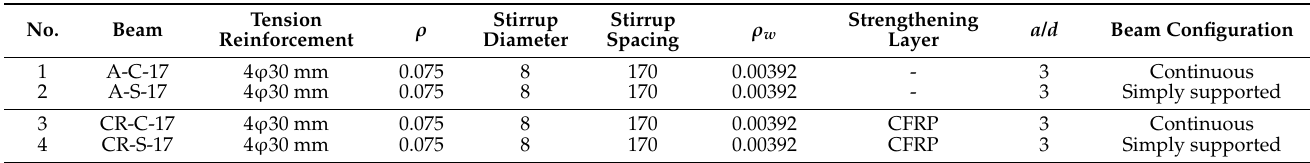
Figure 2. Schematic diagram of the loading position, support conditions, and the reinforcement detailing of the beams [37]. Table 2. Details of beams in the experimental work (adapted with permission from [37]; copyright 2006 American Concrete Institute). (Unit: